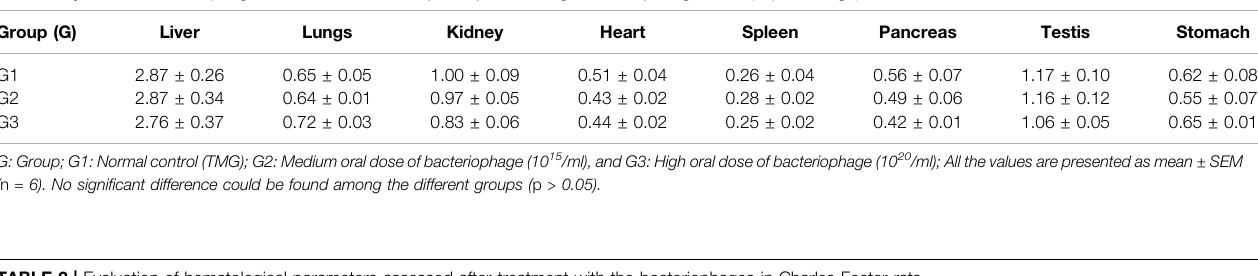
TABLE 2 | Evaluation of hematological parameters assessed after treatment with the bacteriophages in Charles Foster rats. Parameters